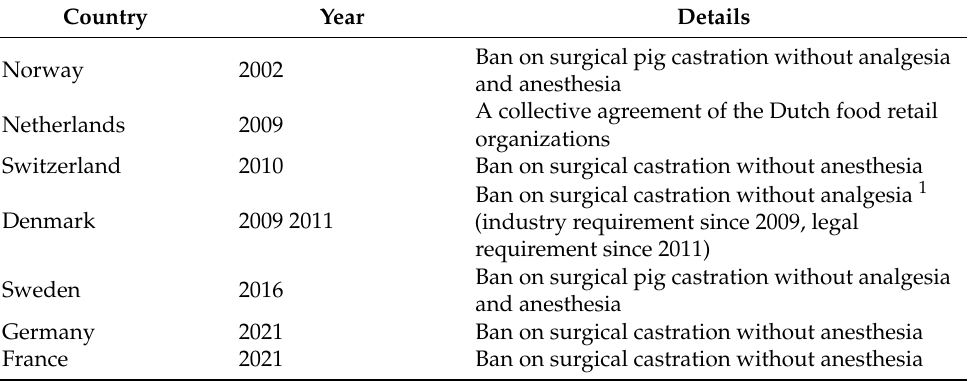
Ban on surgical castration without anesthesia